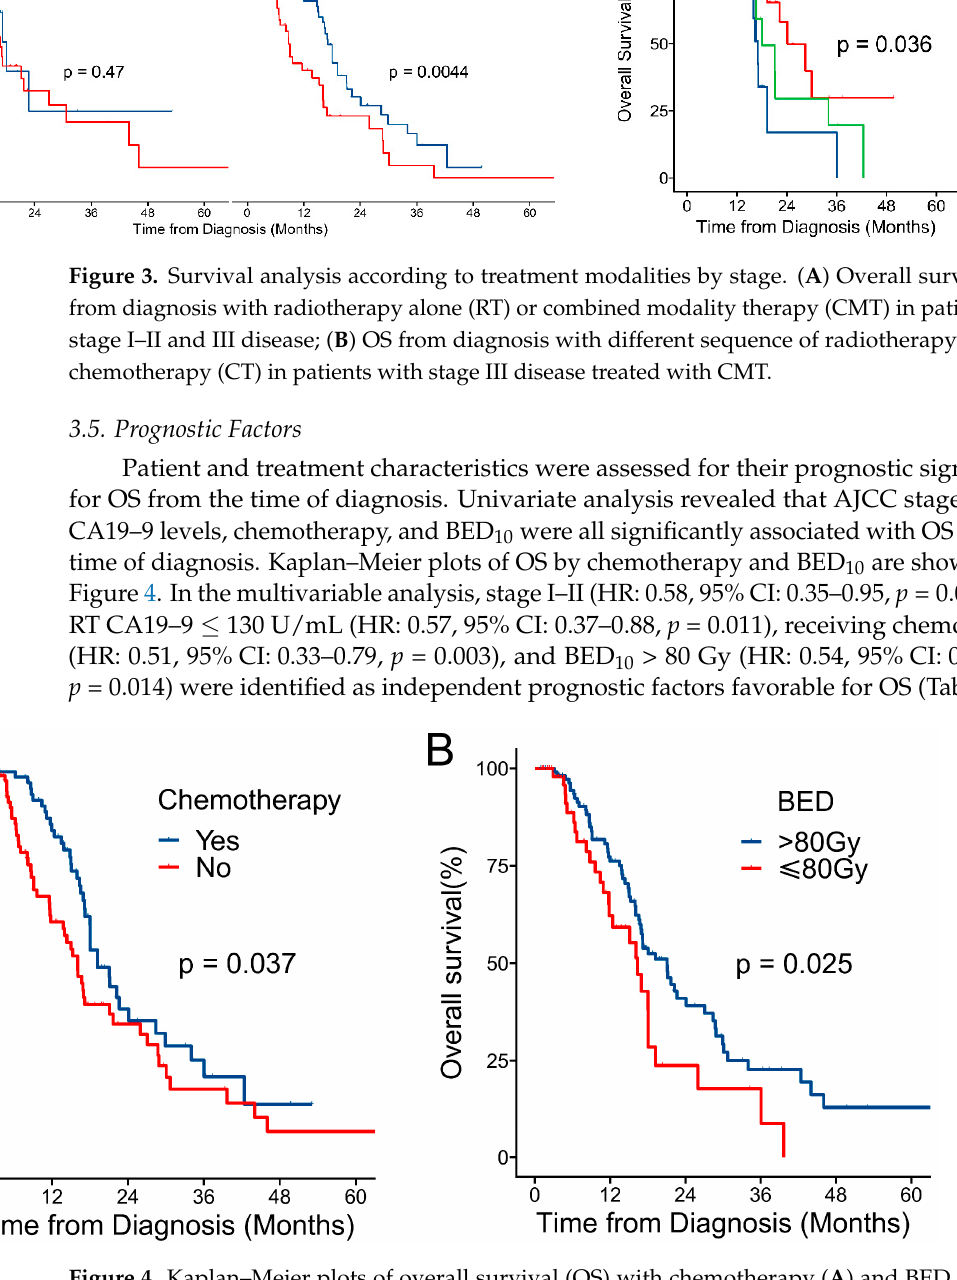
Figure 4. Kaplan–Meier plots of overall survival (OS) with chemotherapy ( A ) and BED ( B ) in the univariate analysis.